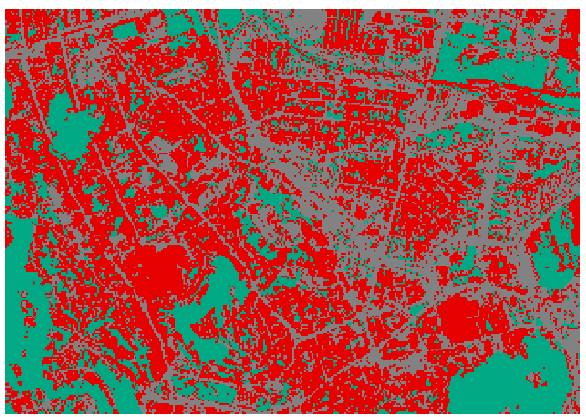
Figure 5 . Classified image for year 2017